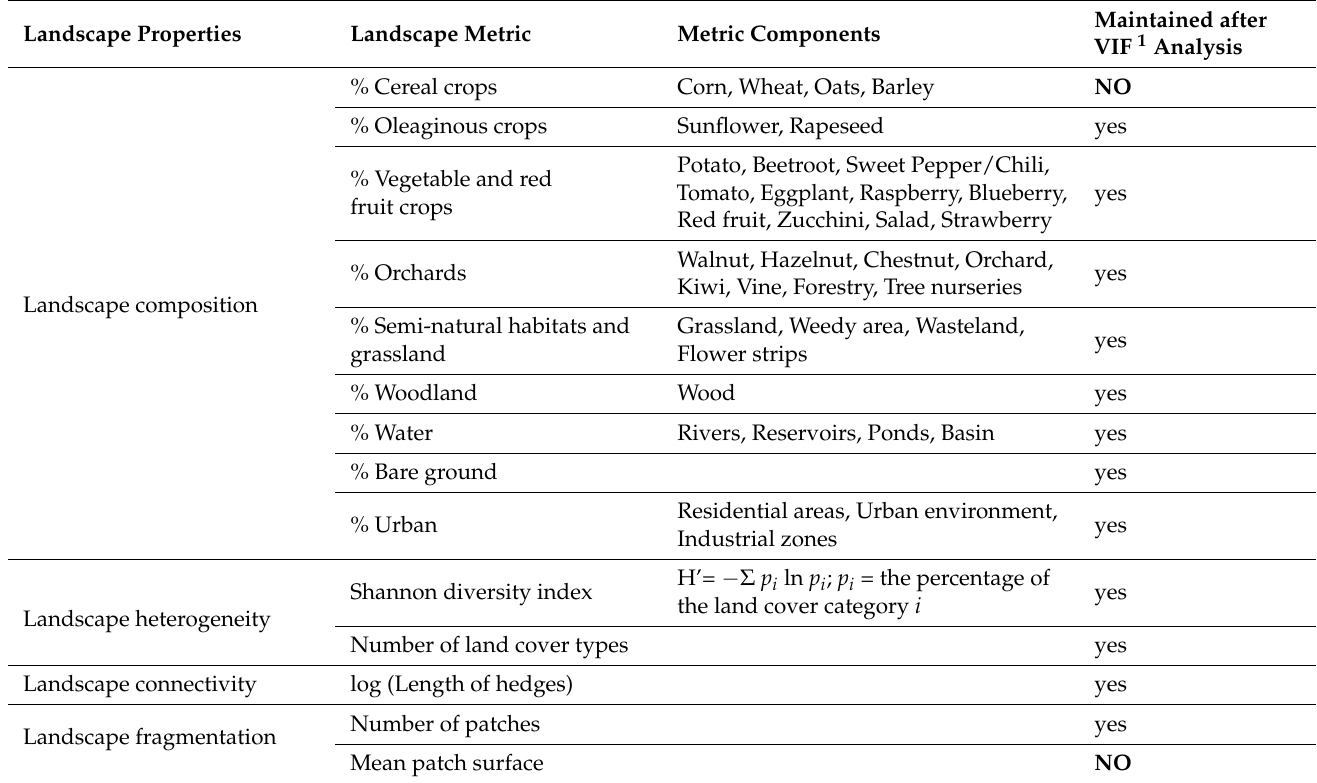
Table 1. List of landscape metrics considered for their effects on insect colonization within greenhouse strawberry